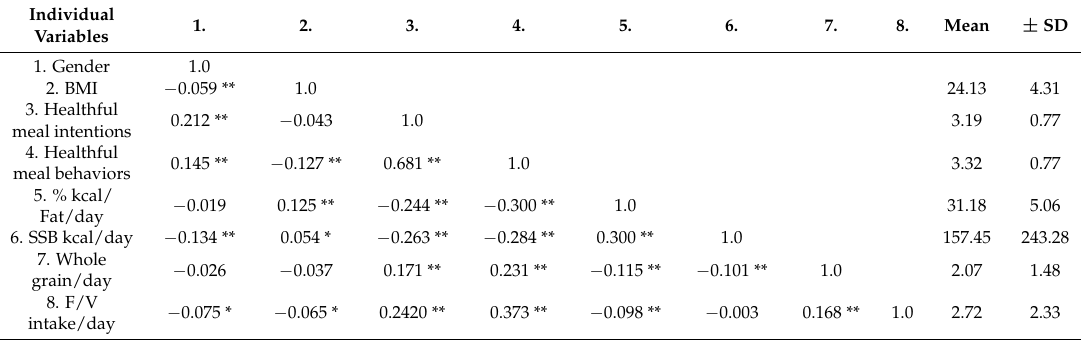
Table 2. Zero-order correlations and means for all study variables ( n =